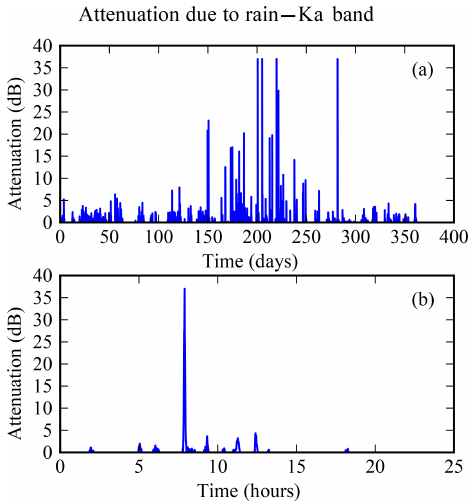
Figure 2. Ka band attenuation measurements operated by ONERA in 2014 (a) for a link between the geostationary satellite Astra 3B and a receiving station located in Toulouse, France. Panel (b) fo- cuses on 19 July